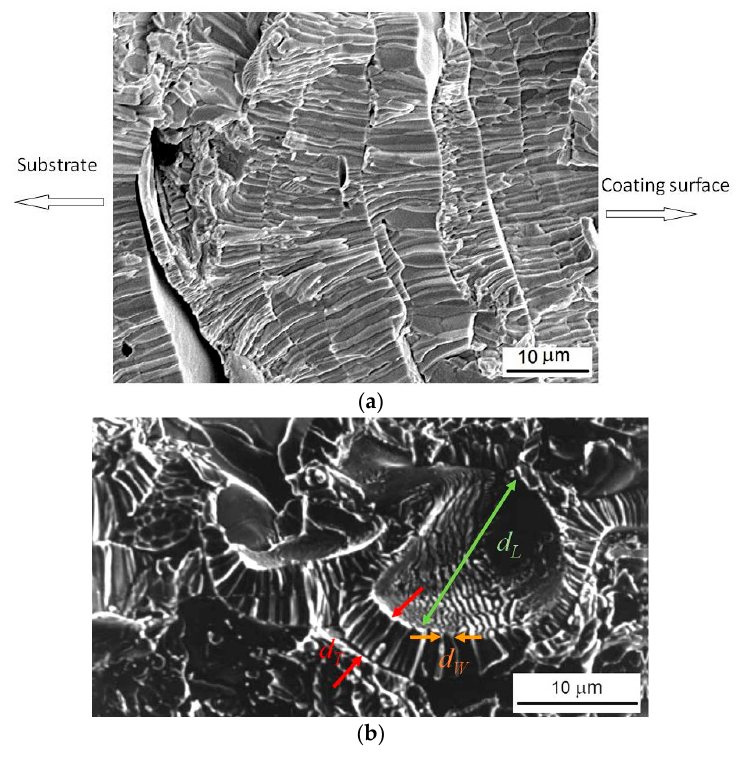
Figure 7. PS W: SEM micrographs of a fracture surface ( a , b ).